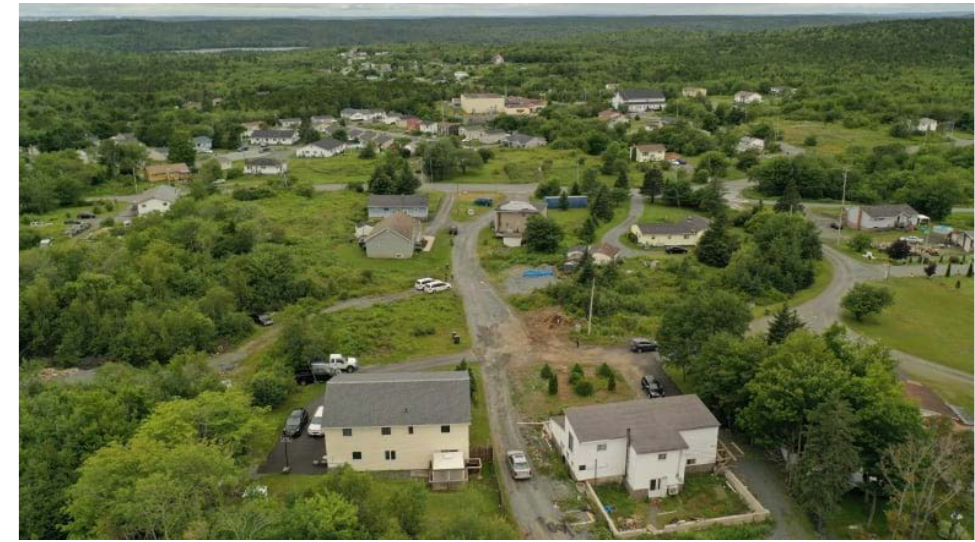
Figure 3. Aerial view of North Preston looking Southeast.